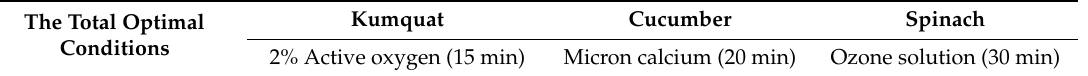
Table 9. The optimal treatments of pesticides in kumquat, cucumber, and